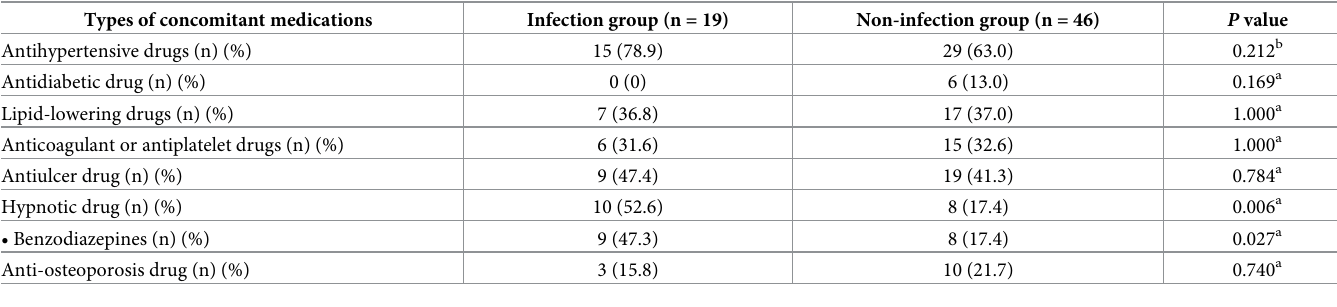
Table 2. Types of concomitant medications.